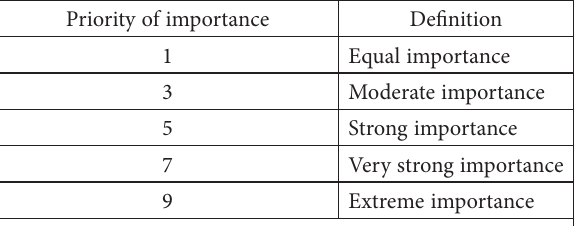
Table 2. From 1 to 9 fundamental scale Priority of importance Definition